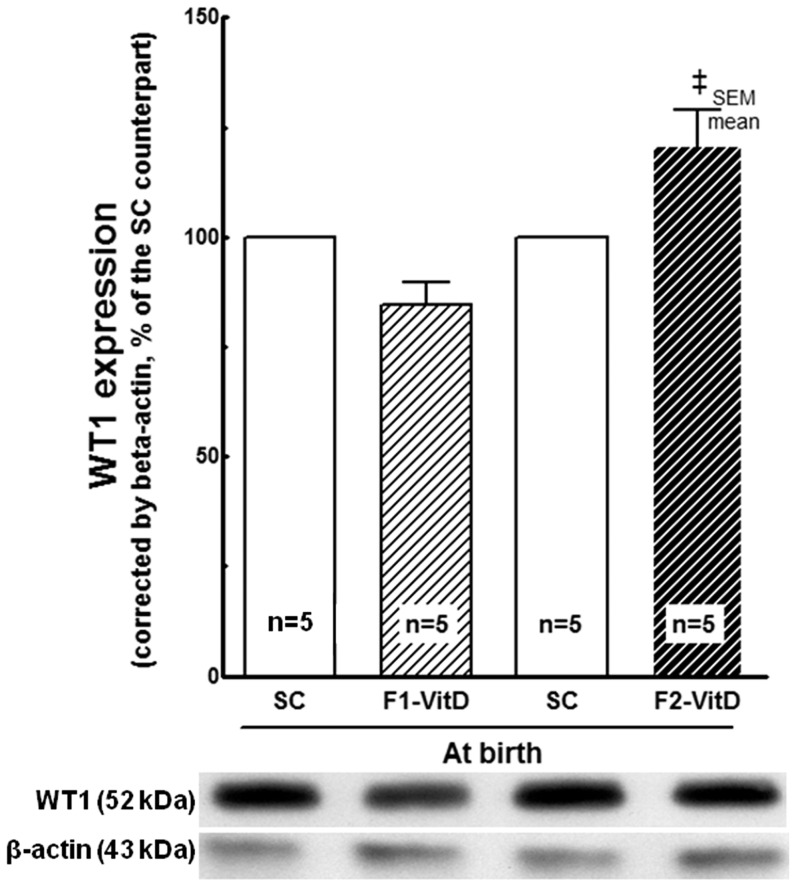
Western blotting analysis of renal tissue at birth for WT1 expression.The average values were measured and equal protein loading was confirmed by probing blots with beta-actin antibody and is expressed into a percentage of the SC counterpart. Data are reported as means ± SEM; P<0.05, one-way ANOVA and post-hoc of Tukey's test: † compared to SC counterpart; ‡ compared to F1 generation.